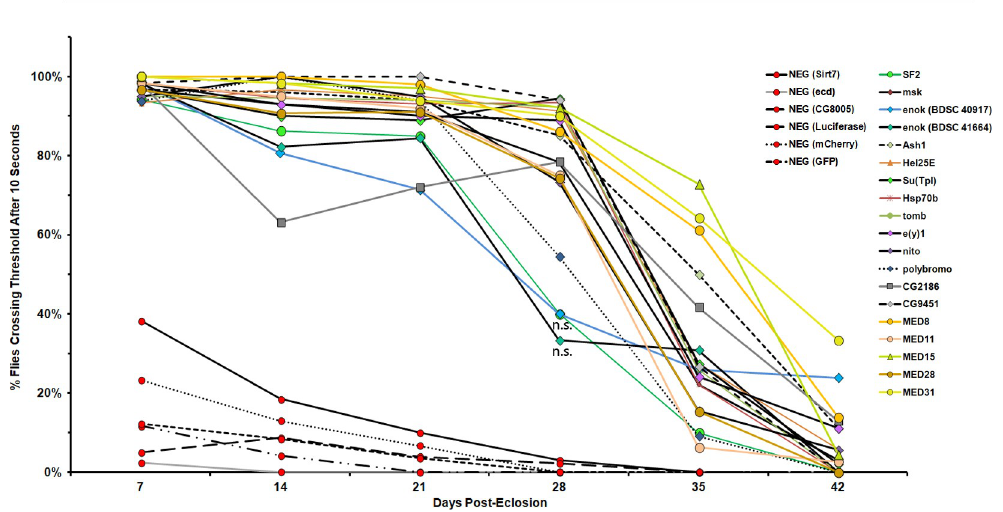
Fig 3. shRNA suppressors rescue the negative geotaxis defect caused by motorneuron-TDP-43 and prevent further age- dependant decline. 25 shRNAs were introgressed into a common wild type Drosophila genetic background w 1118 (iso CJ1), a derivative of CS, and crossed to the TDP-43 screen flies described in Fig 1A . Negative geotaxis was assayed among F1 progeny of each cross beginning 7 days after eclosion and each week thereafter. Negative control shRNAs (Red circles) exhibited severe climbing defects that further deteriorated with each subsequent week. Suppressor shRNAs (non-red data points) ameliorated the effects of TDP-43 in young animals (7 day old) and prevented decline in climbing behavior until the 28 day time point or later. Statistical significance was determined by paired Student’s T-test between suppressor shRNAs and the mCherry negative control shRNA, adjusted for multiple testing by Bonferroni correction. The P value threshold for significance was P < 0.0025. Due to data density on the graph we have indicated significance directly except as noted below. For 7 days after eclosion, all shRNAs were significantly different (P < 0.00001) except for sbr (P = 0.46). Statistical significance was also tested 28 days after eclosion, all shRNAs were significantly different (P < 0.01) except sbr , enok 40917 (blue diamond/blue line data point, P = 0.016) and enok 41664 (green diamond/black line data point, P = 0.0028). Non- significance of the enok data points are indicated by an “n.s.” on the